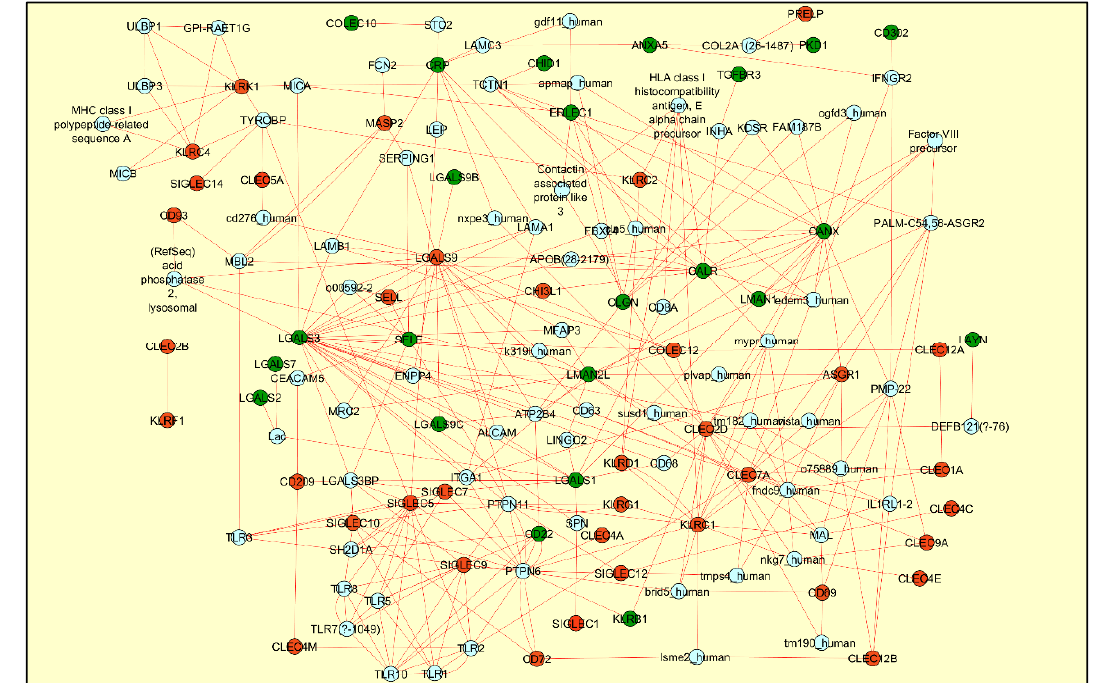
Figure 3. The figure represents the induced network module generated for the differentially regulated lectins using CPDB database and visualized using Cytoscape network. Transcriptomics data from the SARS-CoV-2 infected human nasopharyngeal swab sample was used to highlight the graph with red color indicating upregulated genes and the green color indicating the downregulated genes. The protein–protein interaction network, drawn in red color, reveals the association of lectins with both the positive and negative immune regulatory pathways.